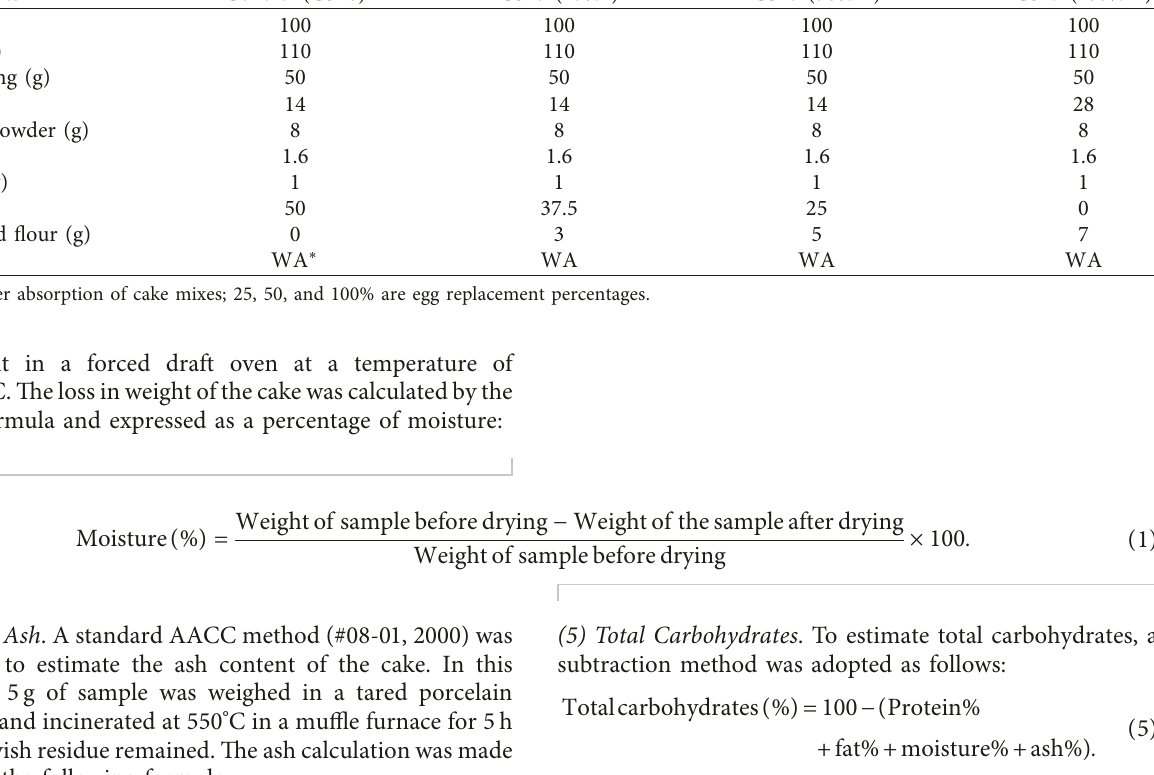
Table 1: Cake formulation prepared by adding different levels of chia seed flour (CSF).